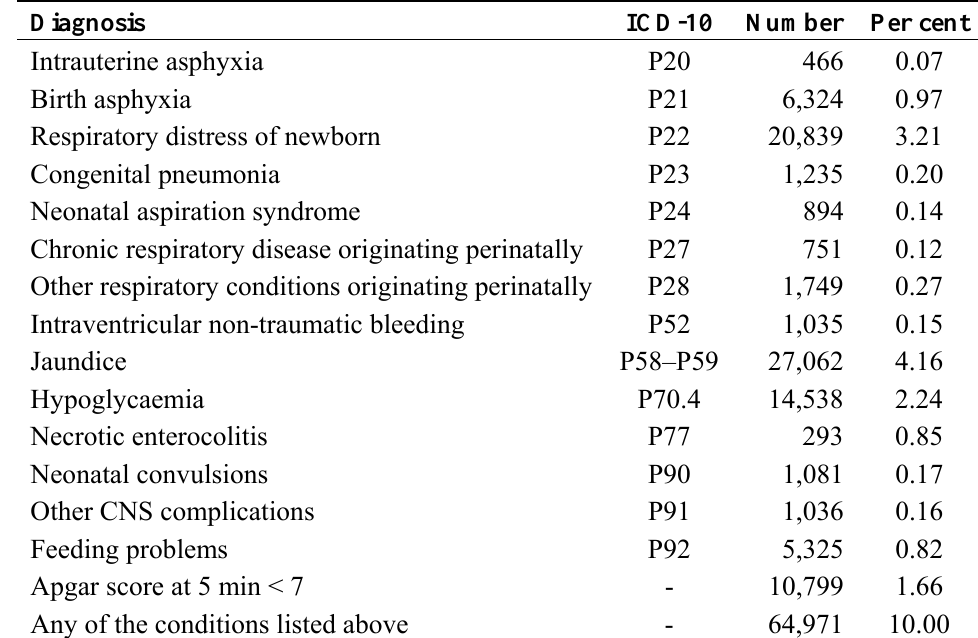
Table 4. Overview of presence of neonatal diagnoses among live born infants, 2006–2011, according to the Medical Birth Register ( n = 650,009).